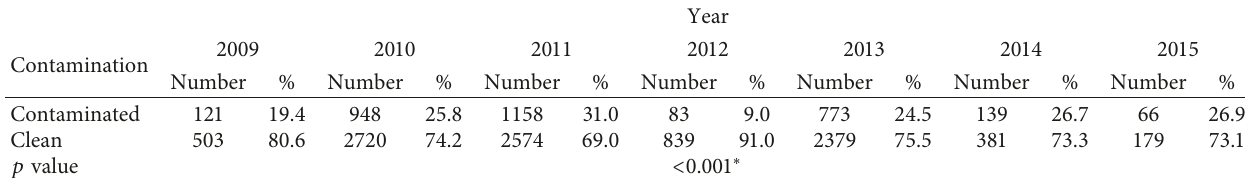
Table 4: Distribution of contamination according to the year of monitoring from different hospitals (2009–2015) in Assiut city.